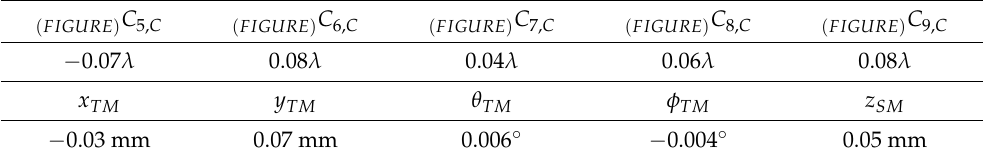
Table 1. The introduced figure errors of PM and misalignments of TM.